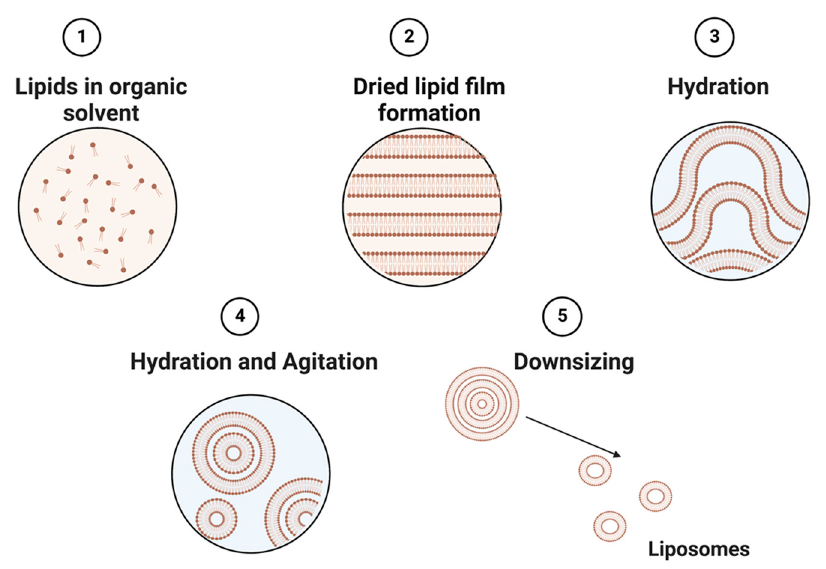
Figure 2. Schematic representation of the main stages of the thin film hydration method of liposome preparation.